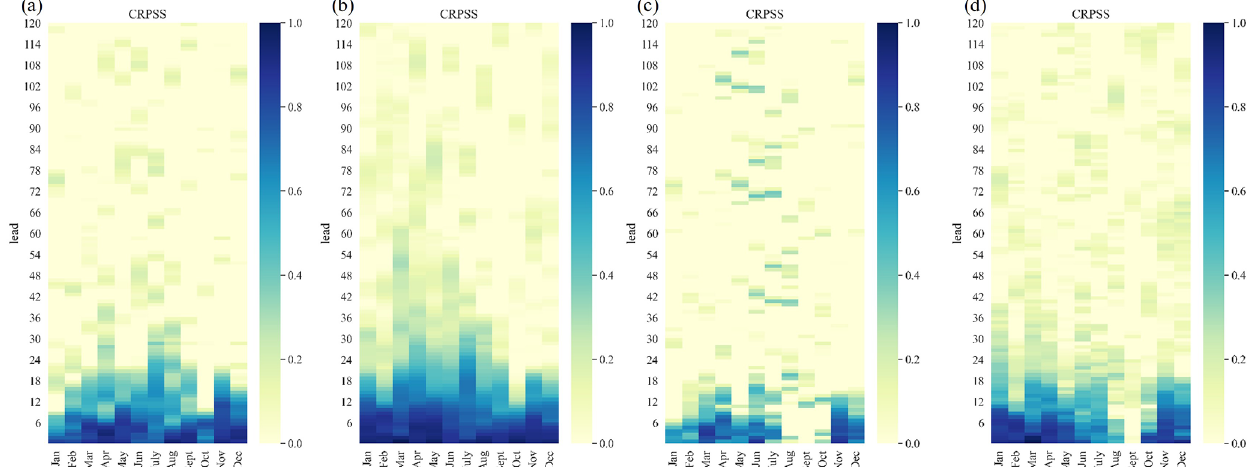
Figure 3. CRPSS (daily) shown for EFAS input data (bias corrected) and hindcasts computed by the hybrid framework for stations Lobith and Eijsden. (a) EFAS at Lobith, (b) hybrid framework at Lobith, (c) EFAS at Eijsden, and (d) hybrid framework at Eijsden. Differences in skill for lead times and also throughout different initialization months can be observed with the hybrid framework, indicating a higher skill for local predictions than the large-scale forecasting system.